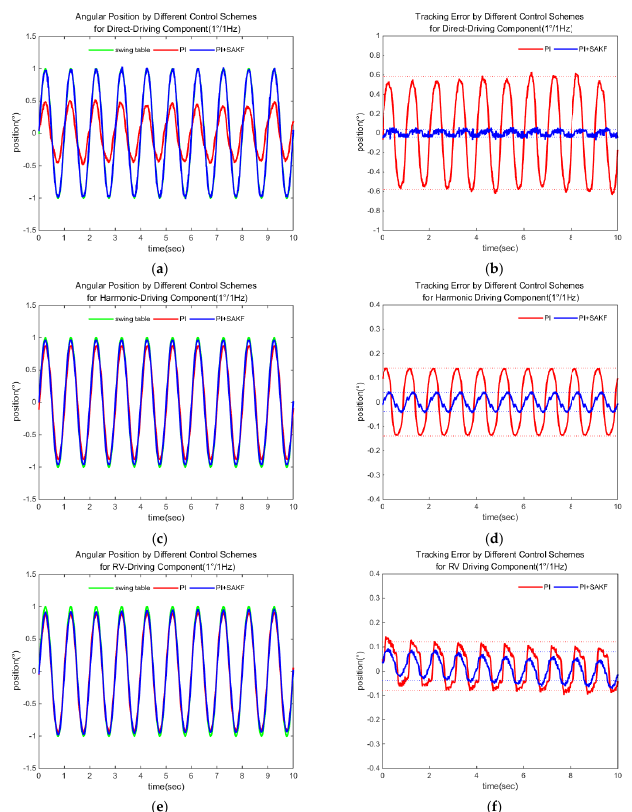
Figure 10. Measured angular position of ( a ) the direct drive component, ( c ) harmonic driving component, and ( e ) RV driving component, and residual motion angle of ( b ) the direct drive component, ( d ) harmonic driving component, and ( f ) RV driving component by PI and PI +SAKF, with the swing table rotating at sinusoidal 1°/1 Hz and the inertial reference speed ω r = 0. The comparison results of the stability accuracy by PI and PI + SAKF are shown in Table 4. It can be seen from Table 4 that, comparing with the PI method, the PI + SAKF can significantly reduce